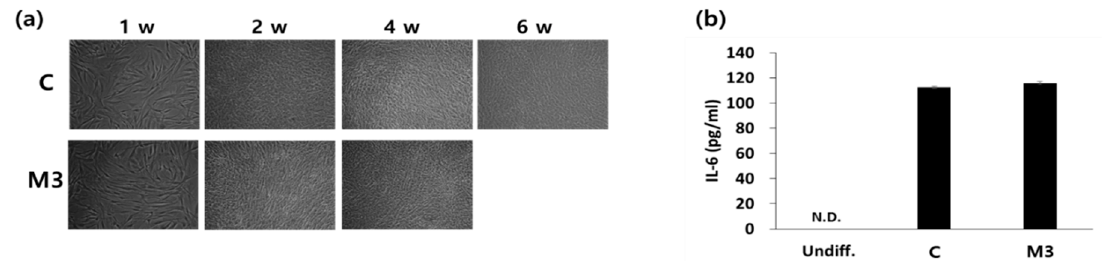
Figure 4. Effect of a combination of IL-6 and C2C12 CM on morphological changes during differentiation and on IL-6 secretion. ( a ) Morphological changes of cells during the differentiation process. ( b ) After 4 weeks (protocol M3) or 6 weeks (protocol C) of differentiation, media were changed to serum-free DMEM and cells were incubated for 24 h. Media were collected and IL-6 levels were measured. w: week(s).